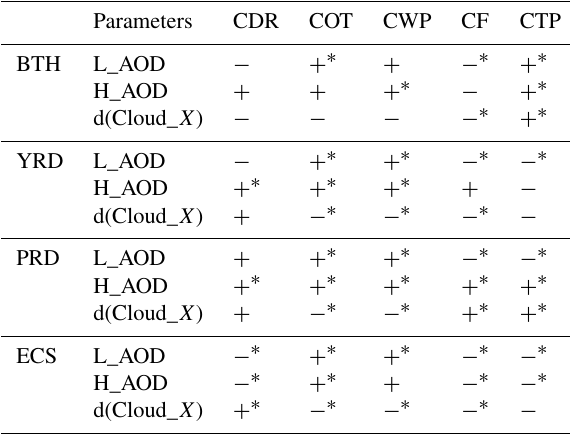
Table 2. Differences in cloud properties between Aqua and Terra for high and low AOD, over land and ocean. Parameters CDR COT CWP CF